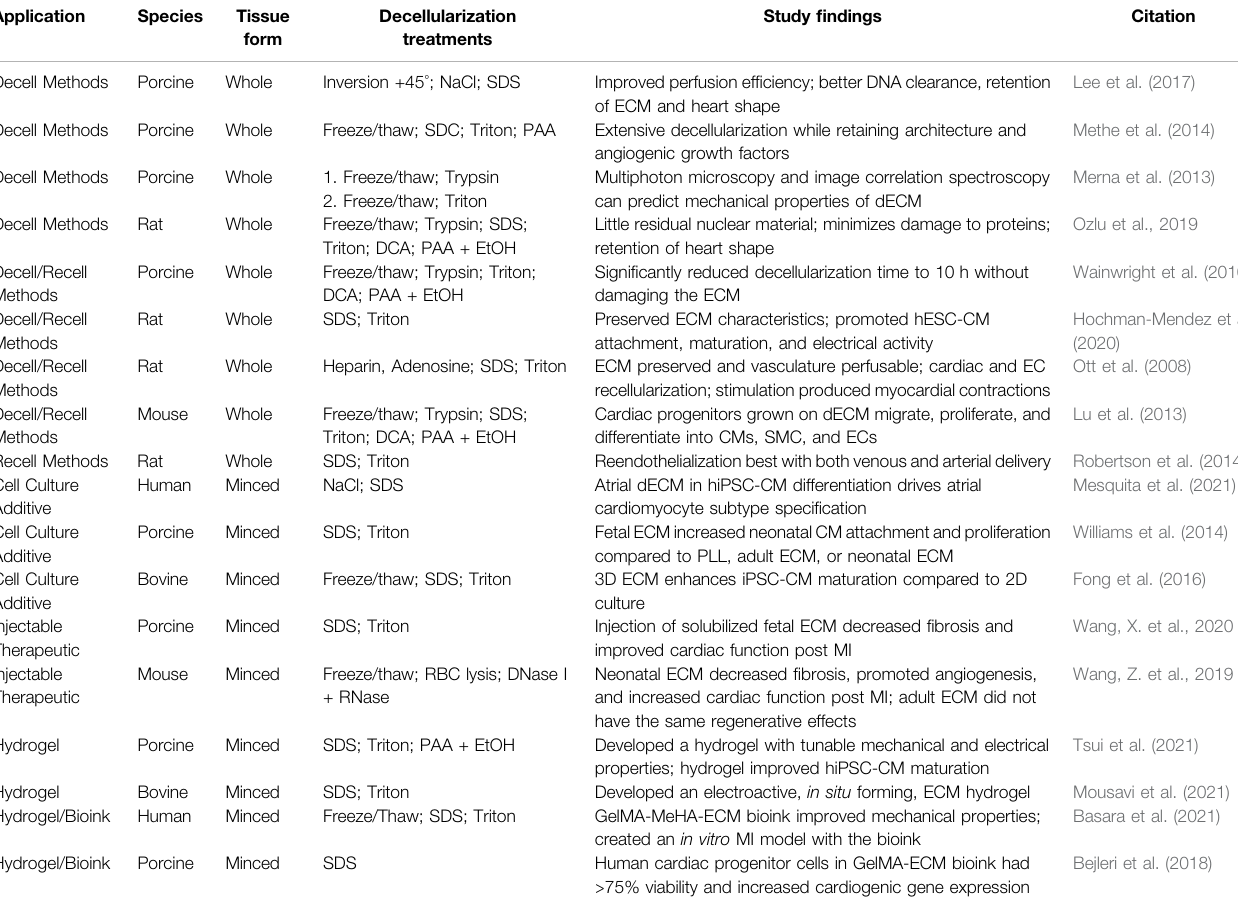
TABLE 1 | Cardiac decellularization